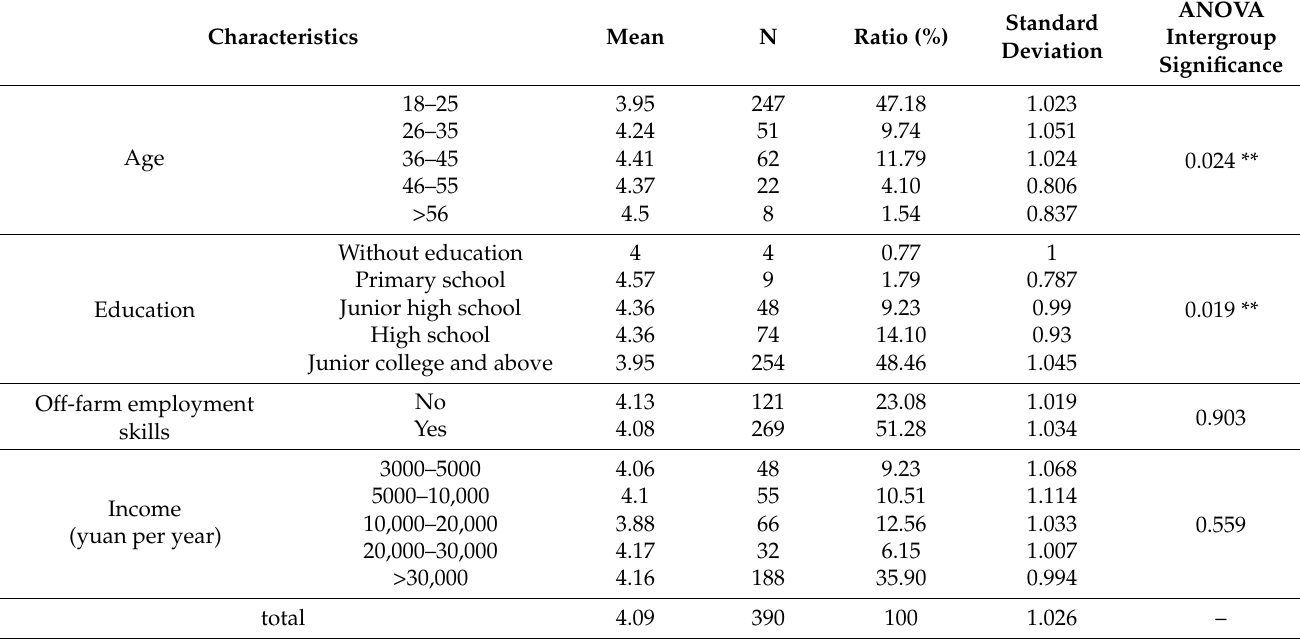
Table 8. The compensation for land reallocation according to the characteristics of